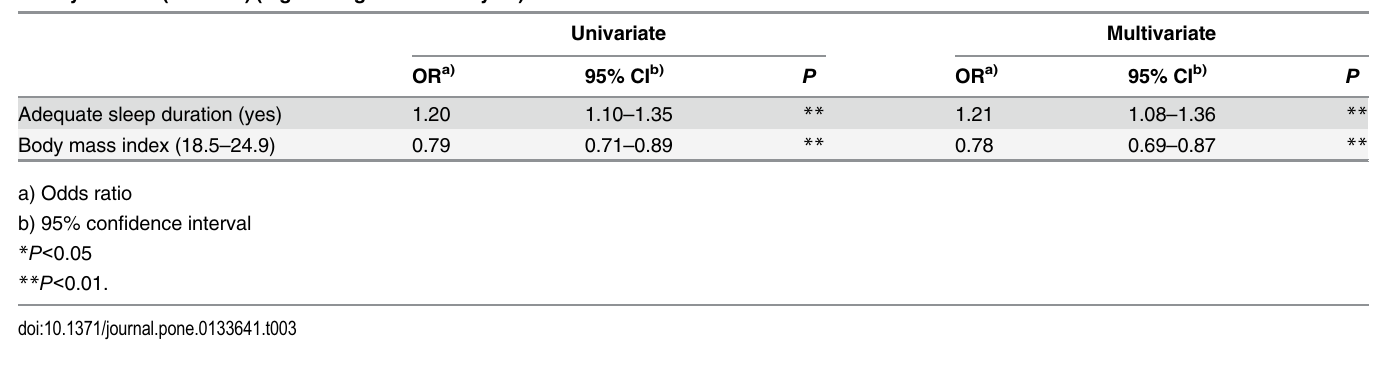
Table 3. Factors associated with therapeutic failure in young, middle-aged, and early-phase elderly patients without diabetes mellitus or chronic kidney disease (n = 5397) (logistic regression